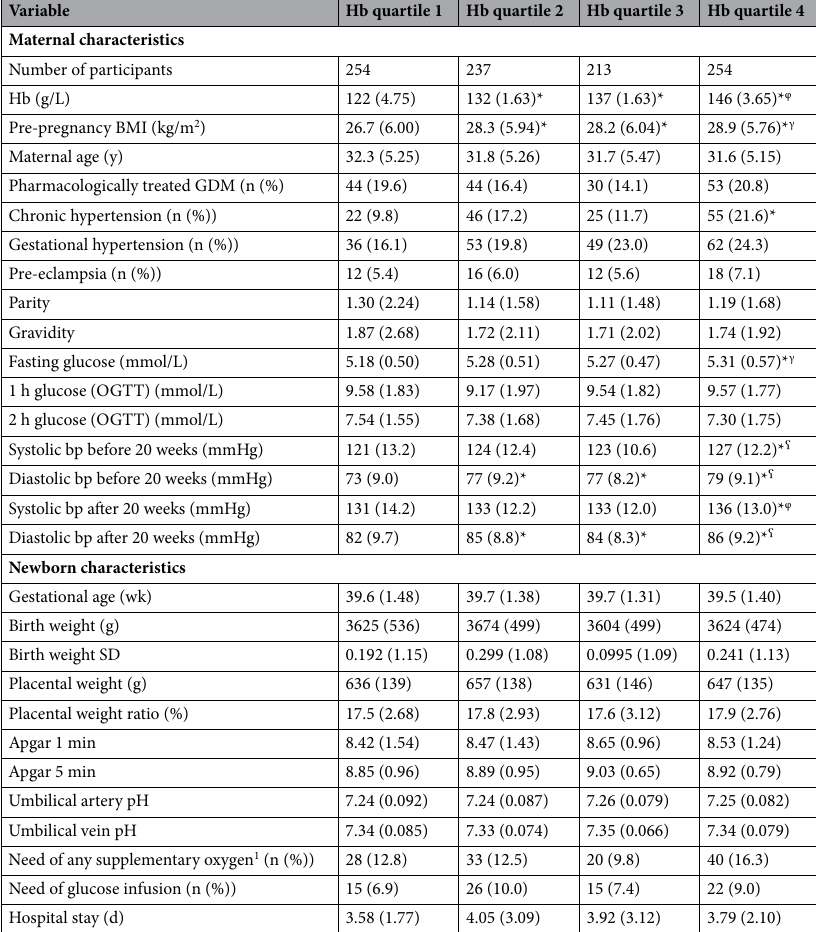
Table 4. Characteristics of the participants with GDM in different Hb quartiles. The values are mean with (SD) or number (n) with (%). Total participants (n = 958). *Statistical significance when compared to Hb quartile 1. γ Adjusted for smoking and the gestational week hemoglobin was measured. φ Adjusted for smoking, the gestational week hemoglobin was measured and pre-pregnancy BMI. ˤ Adjusted for smoking, the gestational week hemoglobin was measured, pre-pregnancy BMI and chronic hypertension. 1 Need of any supplementary oxygen or respiratory support. GDM gestational diabetes mellitus, Hb hemoglobin, BMI body mass index, OGTT oral glucose tolerance test, bp blood